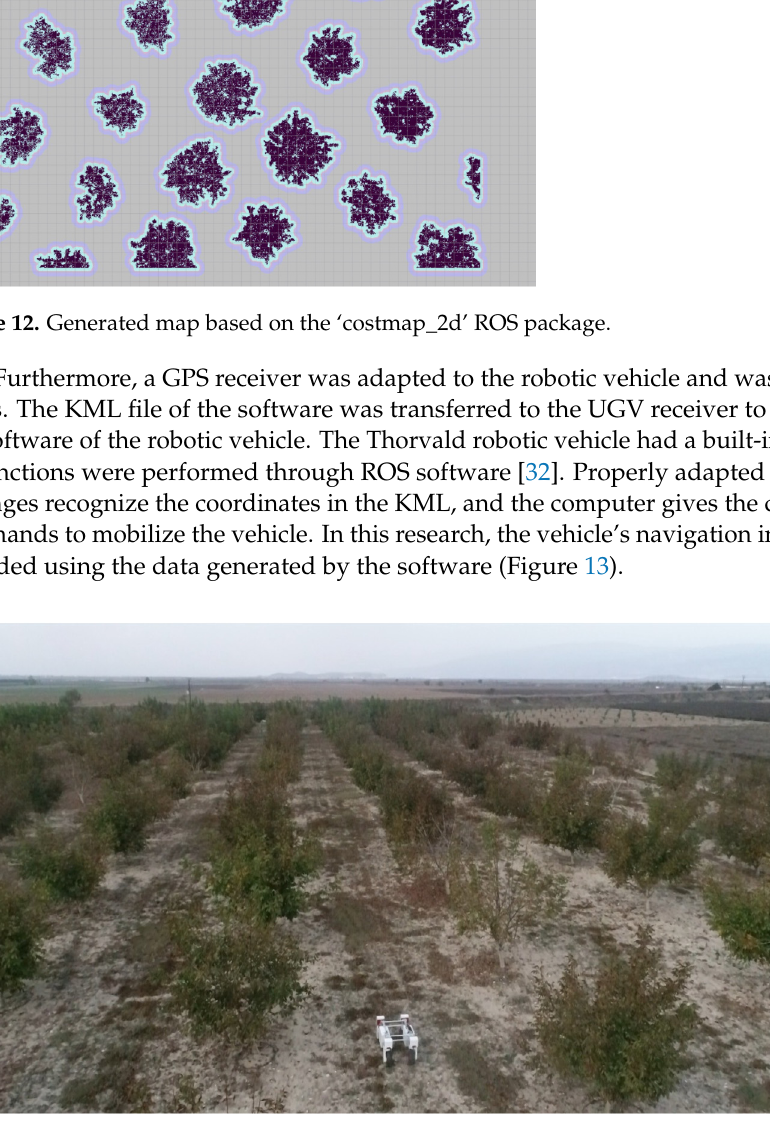
12 of 17 Figure 11. Path planning technique: ( a ) structure and information/data flow; ( b ) UTM coordinates to the topological map; and ( c ) path generation. 4.6. System Integration